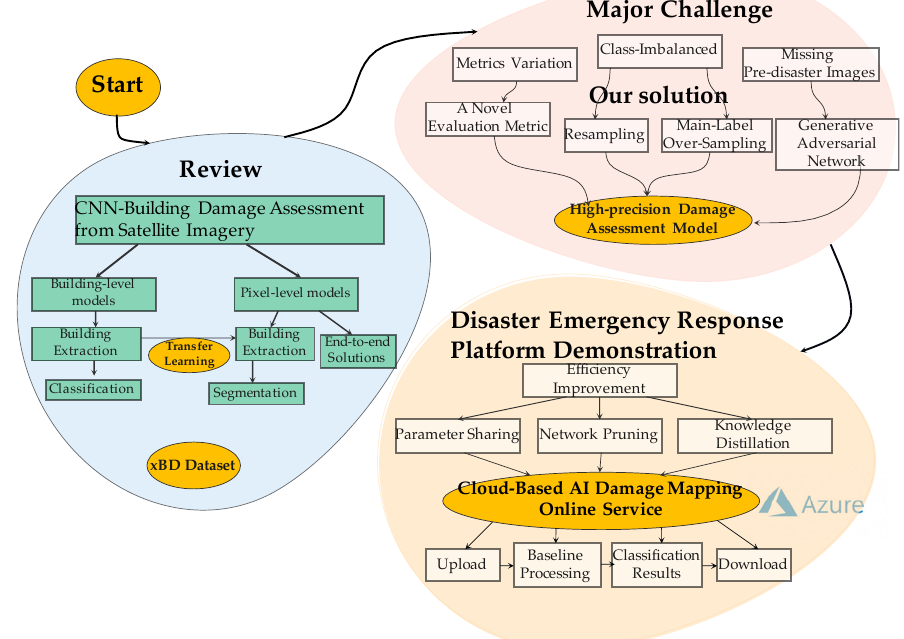
Figure 4. The overall structure of this paper. It contains three main parts and follows the black arrow line from the start point. The first is the review of two categories of building-damage assessment. The second is about four key challenges in this field and proposes some novel solutions. The third is the web-based platform supporting damage detection after